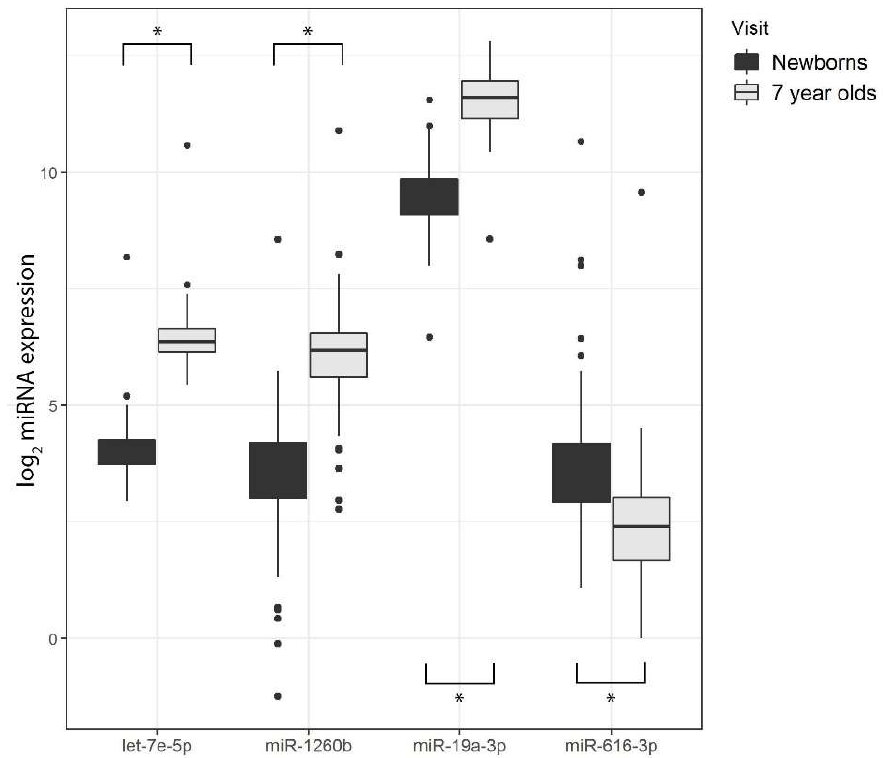
Figure 4. Boxplots of 4 of the 36 miRNAs differentially expressed between visits. As an example, distributions of four miRNAs that were differentially expressed between newborns and 7-year-olds are shown here. The first three box plots show higher miRNA expression in 7-year-old children for let-7e-5p, miR-1260b, and miR-19a-3p, while miRNA expression was actually higher in newborns for miR-616-3p. Asterisks ( * ) indicate statistically significant associations (FDR-adjusted p -values < 0.05).